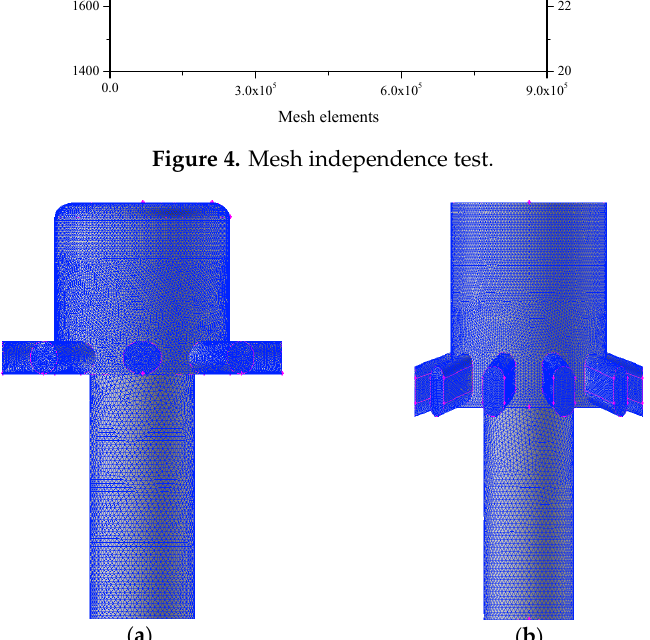
Figure 5. Mesh of bell-type air nozzle: ( a ) nozzle A; ( b ) nozzle B.